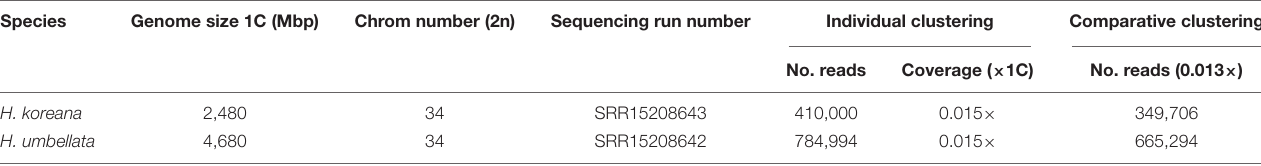
TABLE 1 | Estimation of genome size and sequencing of the two Heloniopsis species studied. Species Genome size 1C